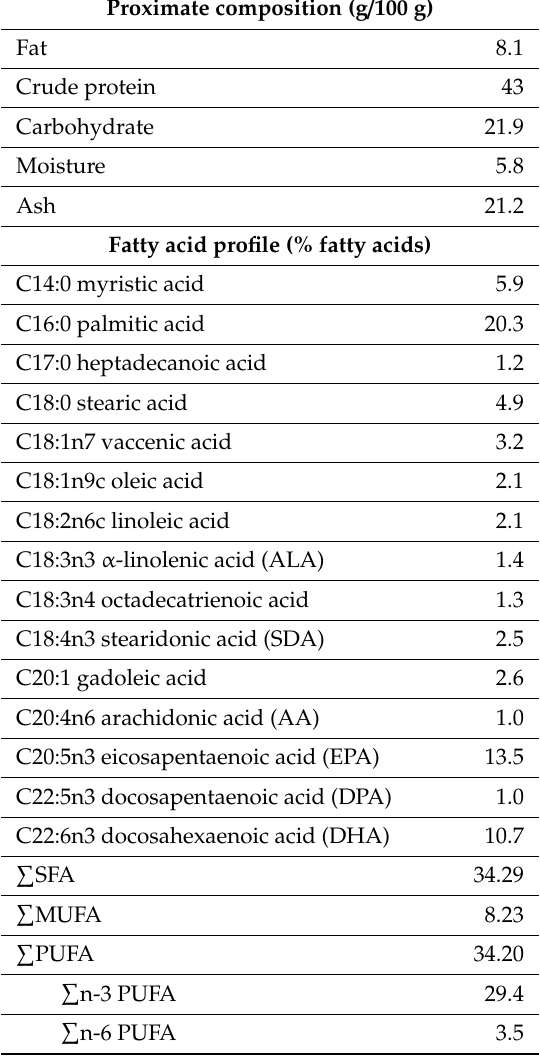
Table 1. Nutritive value of Greenshell mussel (GSM) powder and the composition of fatty acids. Proximate composition (g / 100 g) Fat 8.1 Crude protein 43 Carbohydrate 21.9 Moisture 5.8 Ash